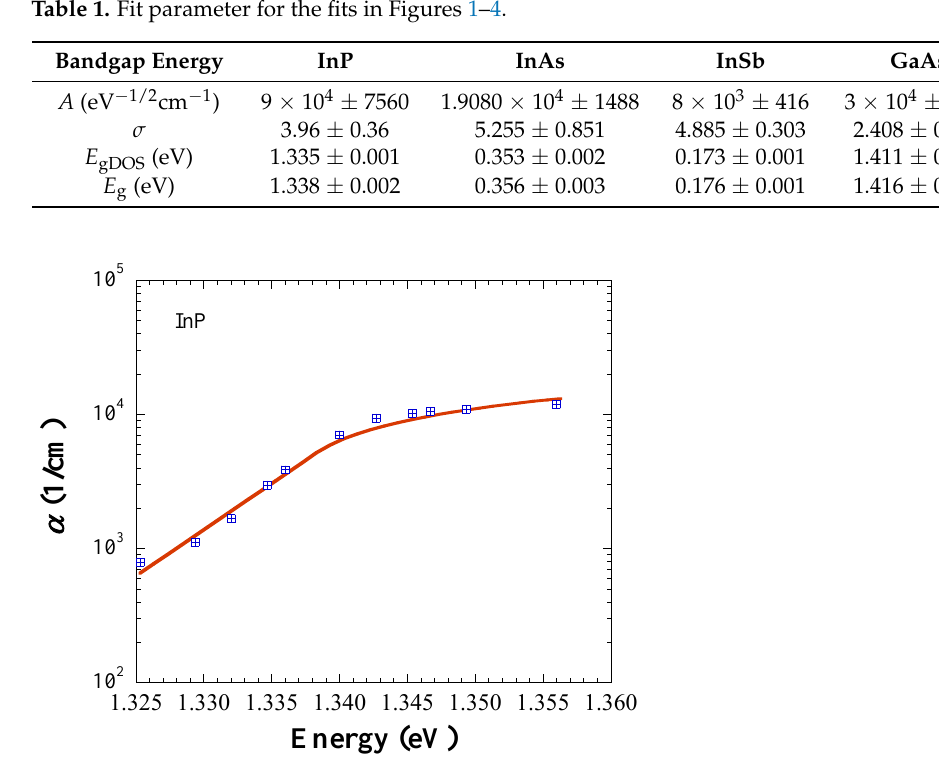
Figure 1. Absorption coefficient of InP. The symbols are retrieved from Ref. [7], and the solid line represents the fit with Equations (5) and (6).